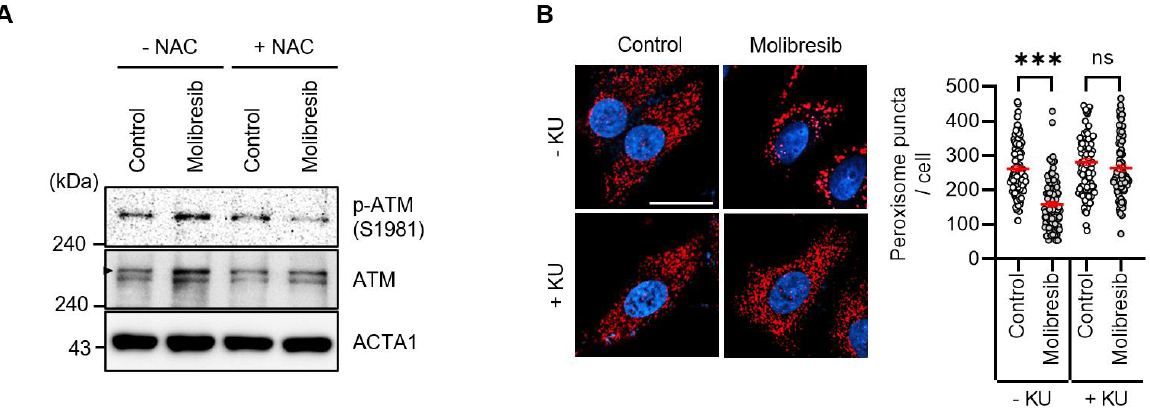
Figure 4. Inhibition of BRD4 activates ATM to promote pexophagy in HeLa cells. ( A ) HeLa cells were treated with molibresib (10 µ M) with or without NAC (1 mM) for 48 h. The cells were harvested and analyzed by Western blotting with the indicated antibodies; ( B ) HeLa cells were treated with molibresib (10 µ M) with or without KU55933 (10 µ M) for 48 h. Then, the cells were immunostained with anti-ABCD3 antibody (red) and Hoechst 33,342 dye (blue) to count the peroxisomes. Representative cell images are presented (scale bar 20 µm). The experiments were repeated at least three times. (Data indicate means S.E.M. *** p < 0.001, ns: not significant).